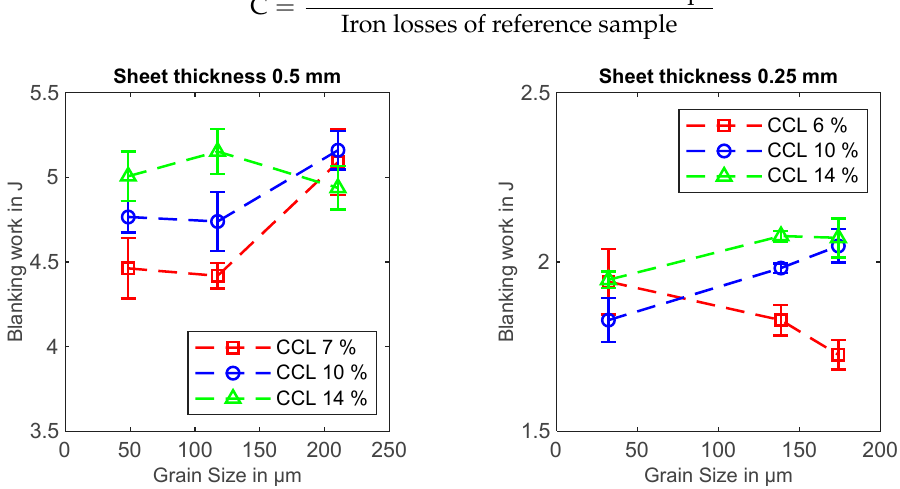
Figure 4. Blanking work in dependence of the average grain size for sheet thicknesses of 0.25 mm or 0.5 mm and for cutting clearances of 6%, 7%, 10% and 14%. Error bars show the standard deviation of the blanking work.